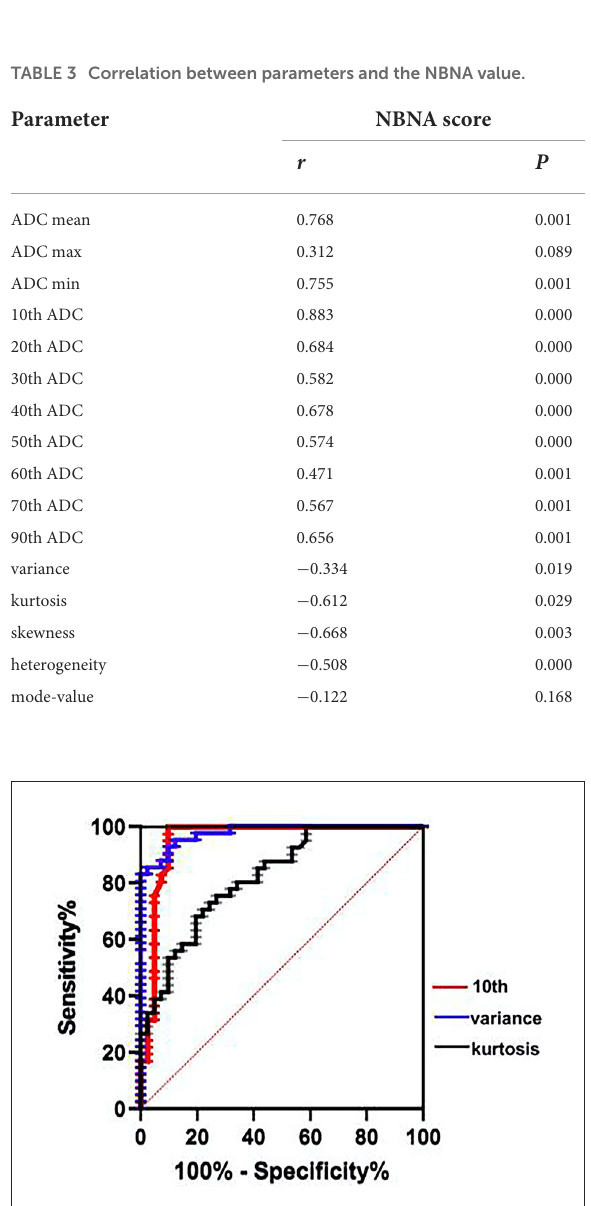
FIGURE5 ROC curve indicated that the variance has the greatest diagnostic efficacy for the moderate-to-severe HIE (cut-off = 972.5, sensitivity 95.12%, specificity 87.8%), followed by the 10th percentile of ADC value (AUC = 0.954), the kurtosis (AUC = 0.878). ROC, receiver operating characteristic; AUC, area under the